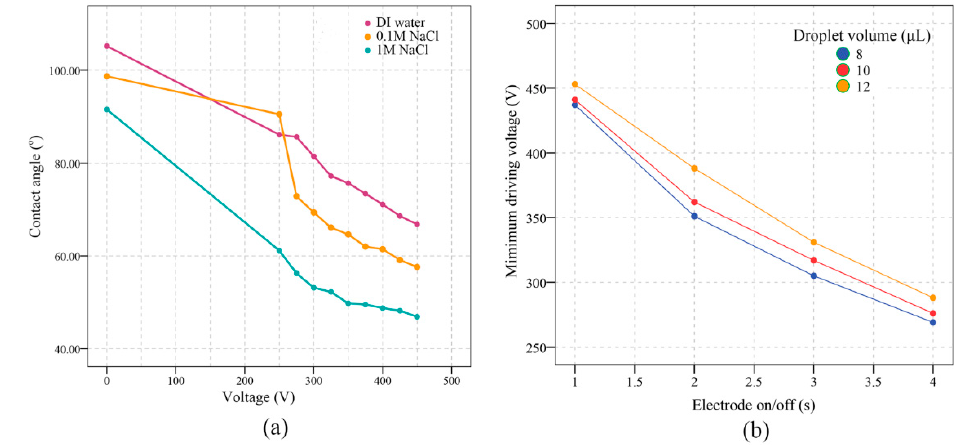
Figure 9. ( a ): Measured contact angle under different voltages (the frequency of the AC voltage supply is 1 kHz, with droplet volume of 10 µ L). ( b ): Minimum driving voltages with the different electrode on/off time in the proposed digital microfluidic